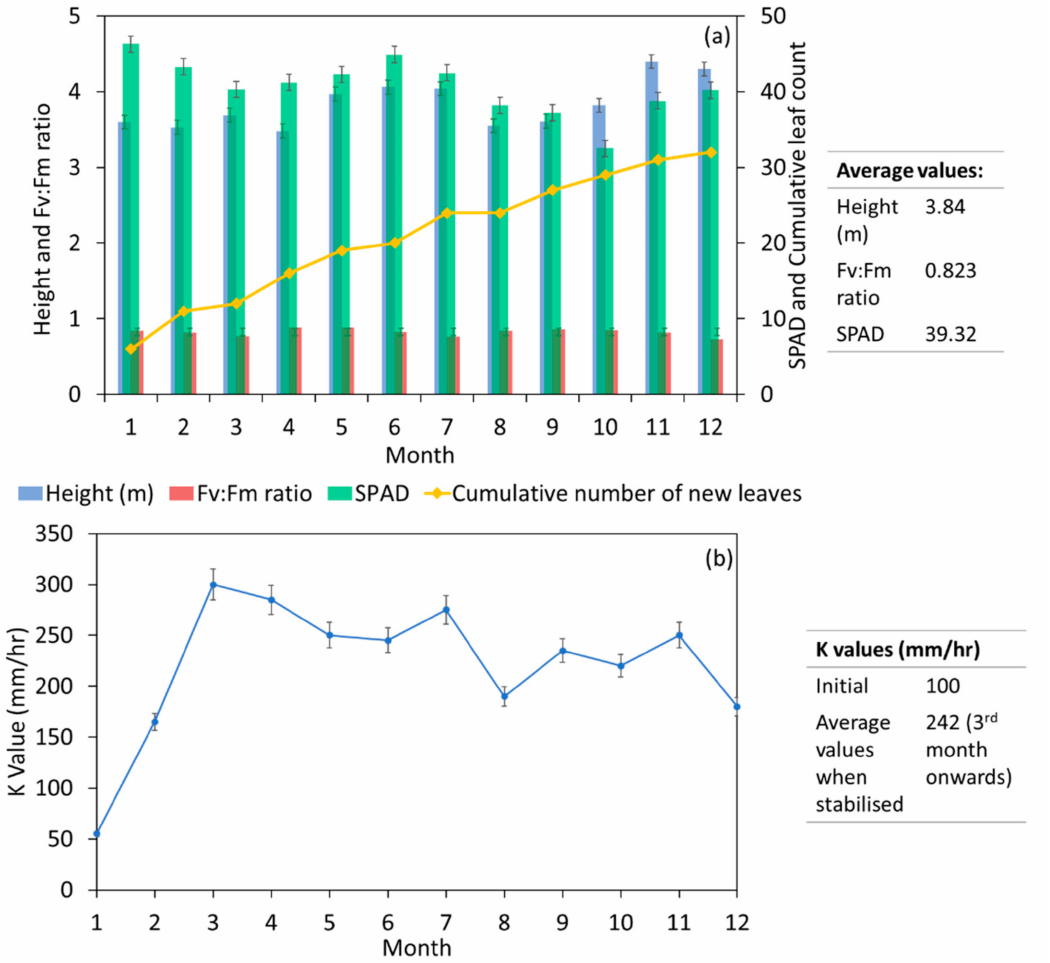
Figure 7. ( a ) Plant growth indices in the MBT system and ( b ) Soil conductivity